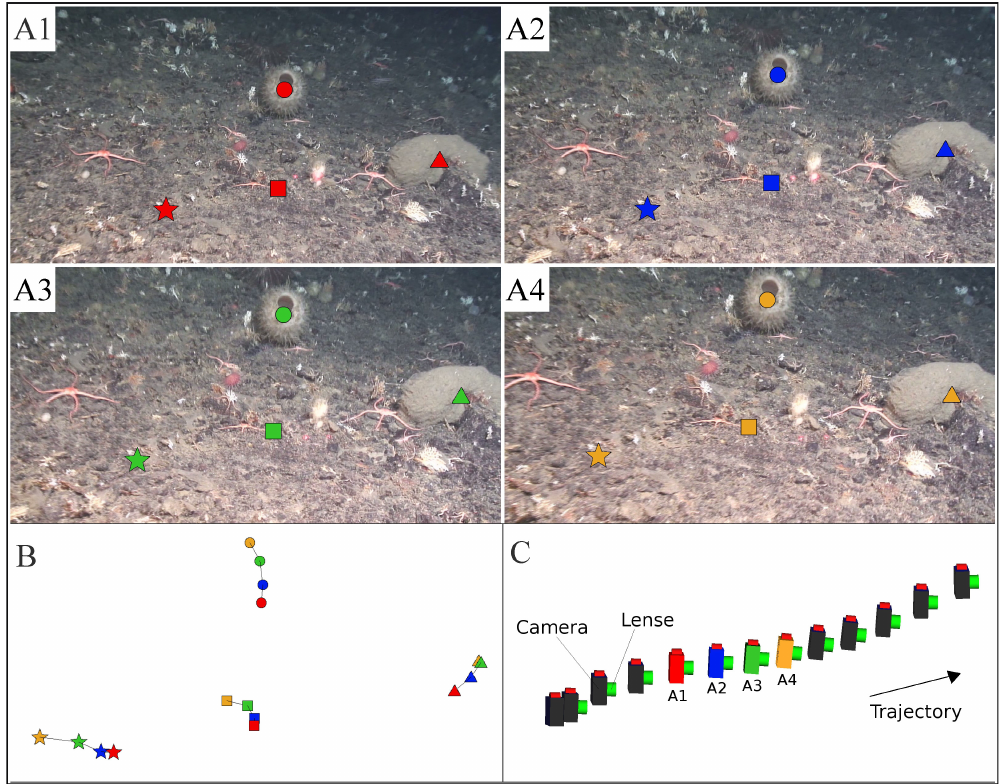
Fig. 3. SmartPoints matching and camera position reconstruction in PhotoModeler. (A1–4) Position of 4 SmartPoints identifying the same features on 4 consecutive frames. (B) Displacements of the 4 SmartPoints along the frames. (C) Reconstructed relative positions of the camera for the 4 previous frames within the